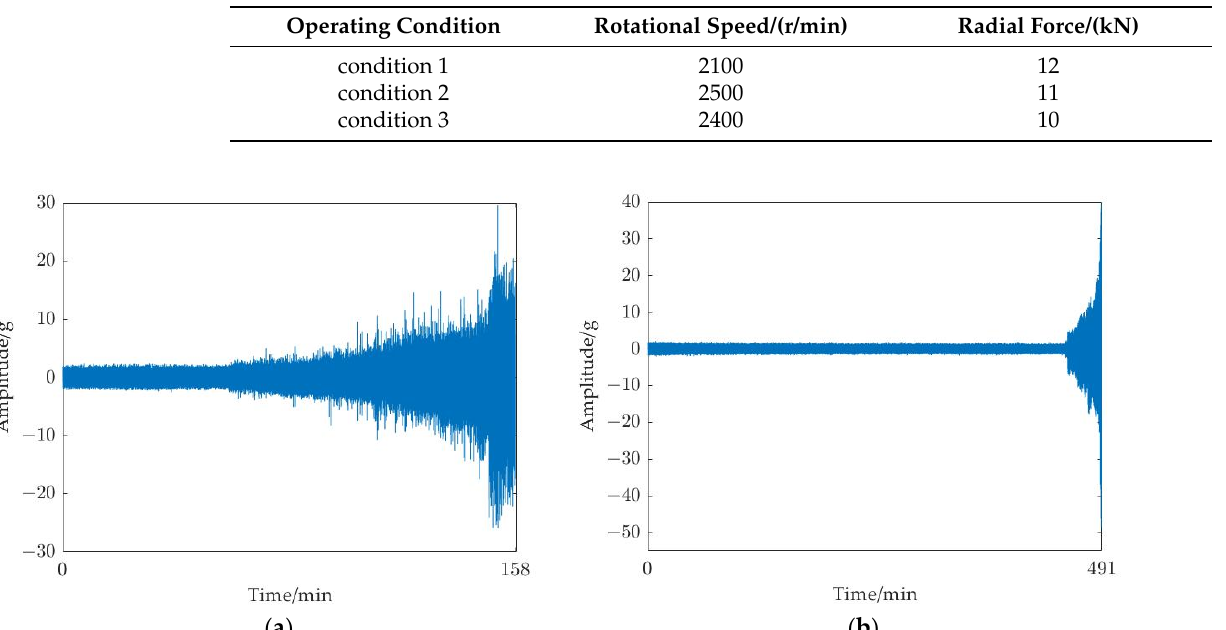
Table 2. Test conditions for XJTU-SY dataset rolling bearings.